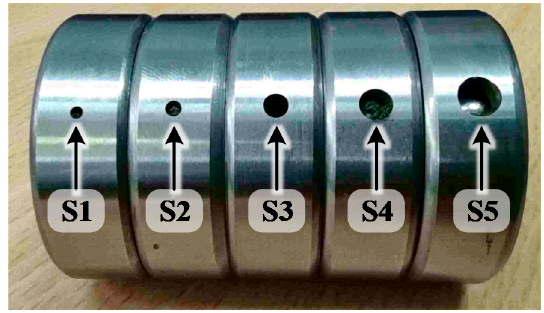
Figure 5. The set of damaged bearings experimentally tested in the IM of an electromechanical systems. The damaged bearings are damaged in their outer race with a severity of damage of: 1 mm (S1), 2 mm (S2), 3 mm (S3), 4 mm (S4), and 5 mm (S5).